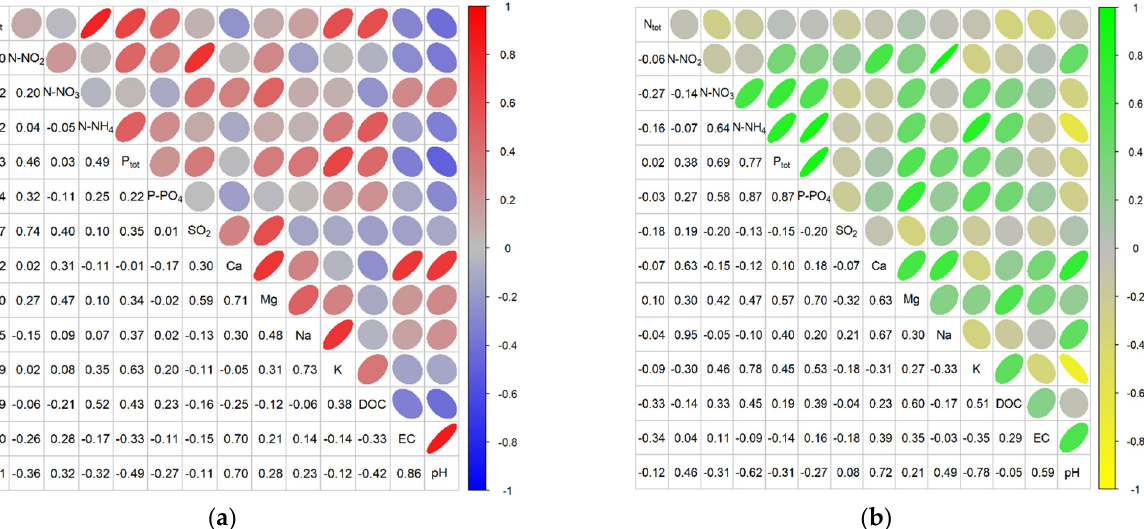
Figure 7. Correlations between physicochemical factors of peatland water as pooled data for Menyanthes trifoliata in 2011–2013 ( a ) abundant sites, ( b ) non-abundant sites.